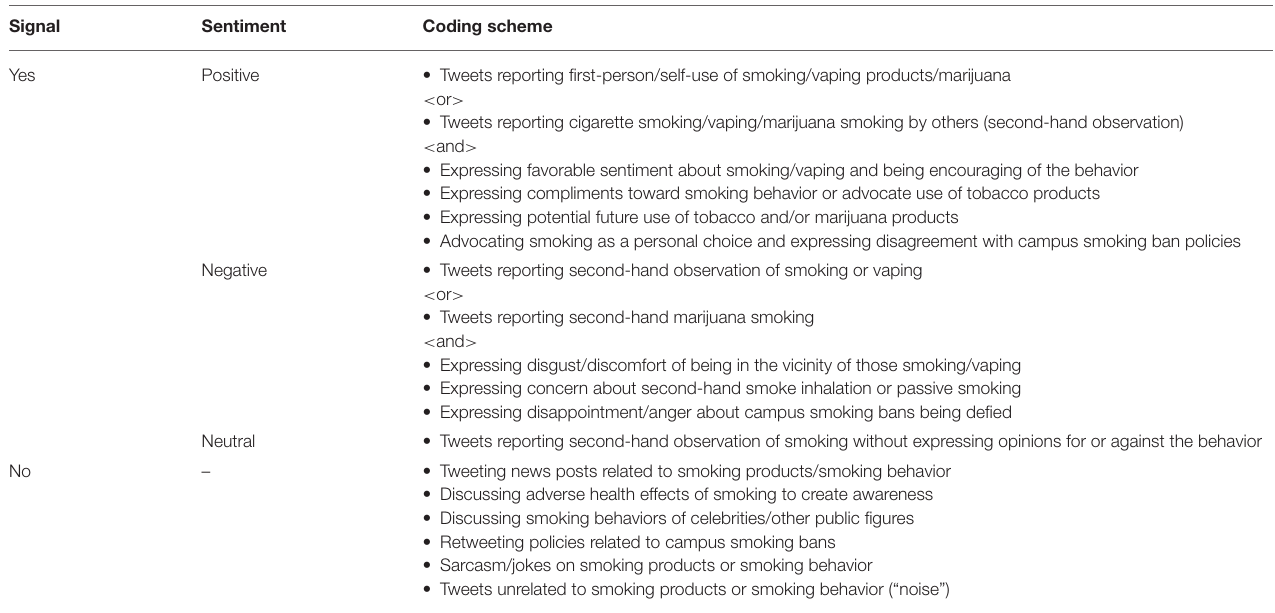
TABLE A1 | Manual annotation scheme used for trinary classification of sentiment and binary classification of first-person use or second-hand observation of smoking behavior.